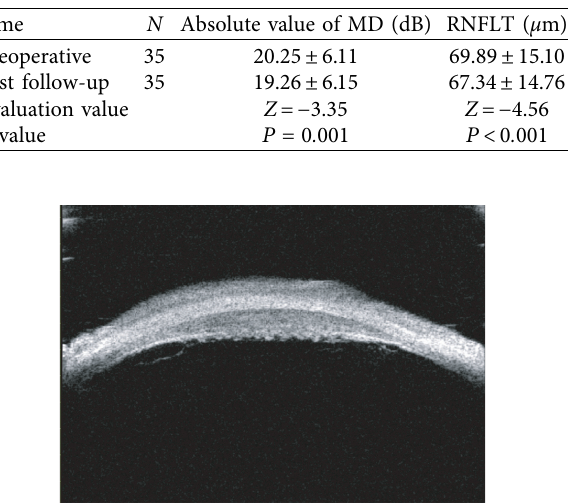
Figure 4: At 12 months postoperatively, ultrasonic biological microscopy shows complete atrophy of the ciliary processes at the photocoagulation